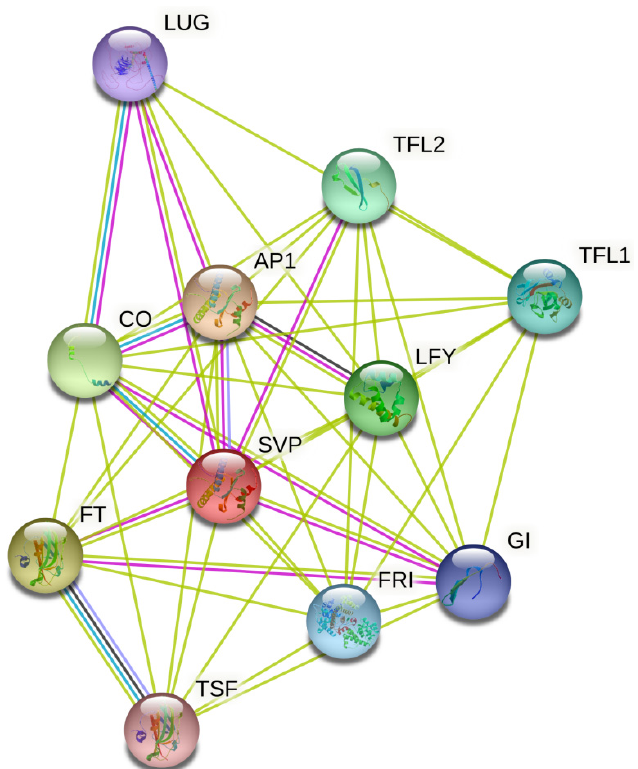
Figure 10. Prediction of the SVP protein interaction network. Loading SVP gene into String 11.0 online tool for protein interaction network prediction (https://string-db.org/, last accessed date 28 February 2022).